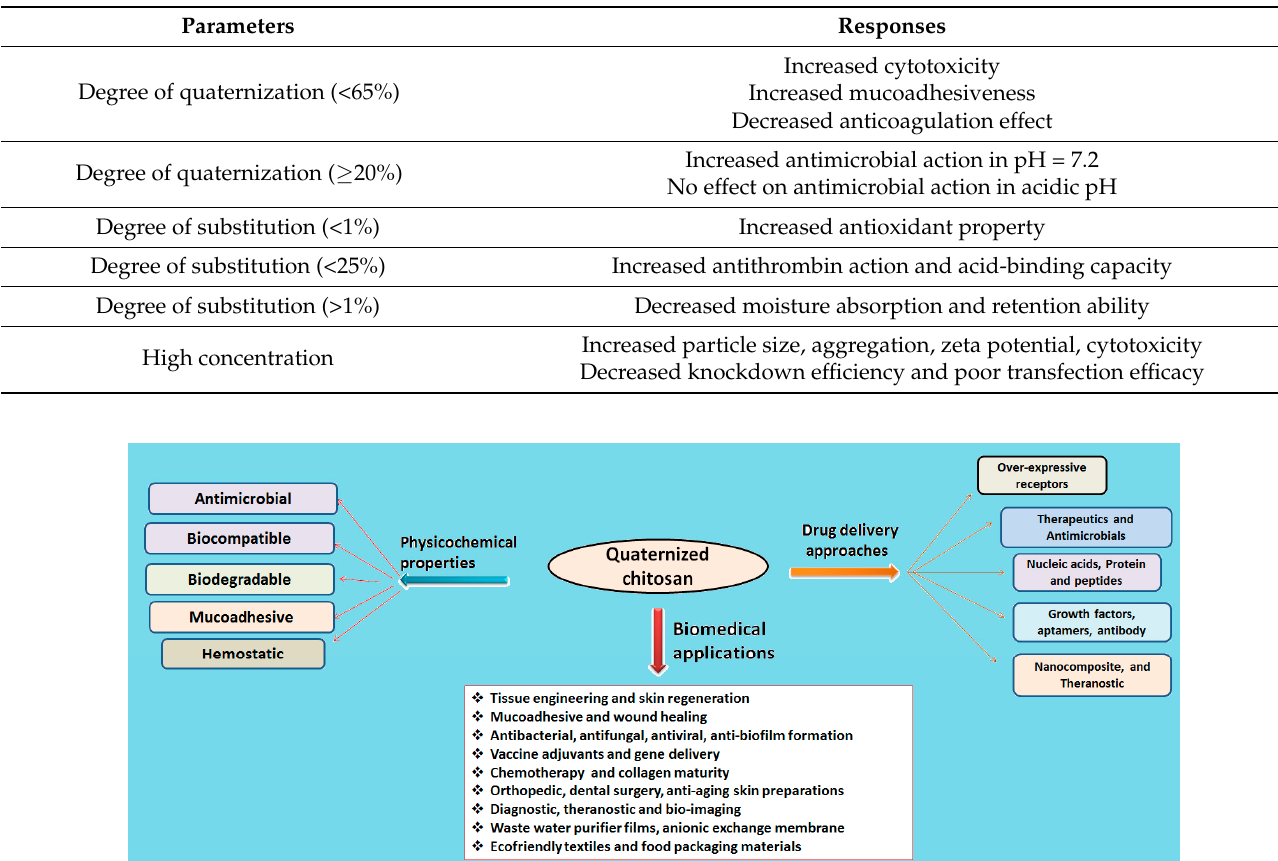
Table 1. Effect of parameters influencing the biological responses [20,21].